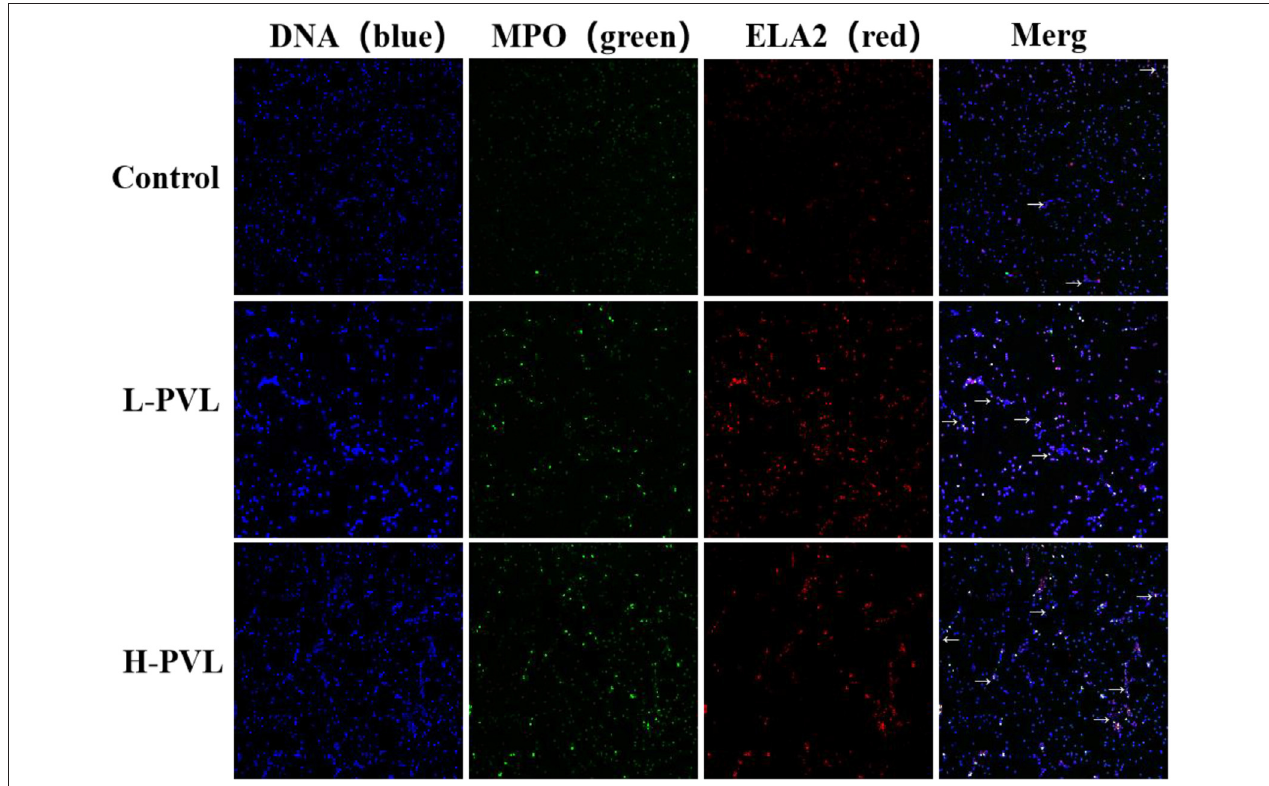
FIGURE 4 | Effect of BLV infection on the formation of PMN NETs (100 × ).